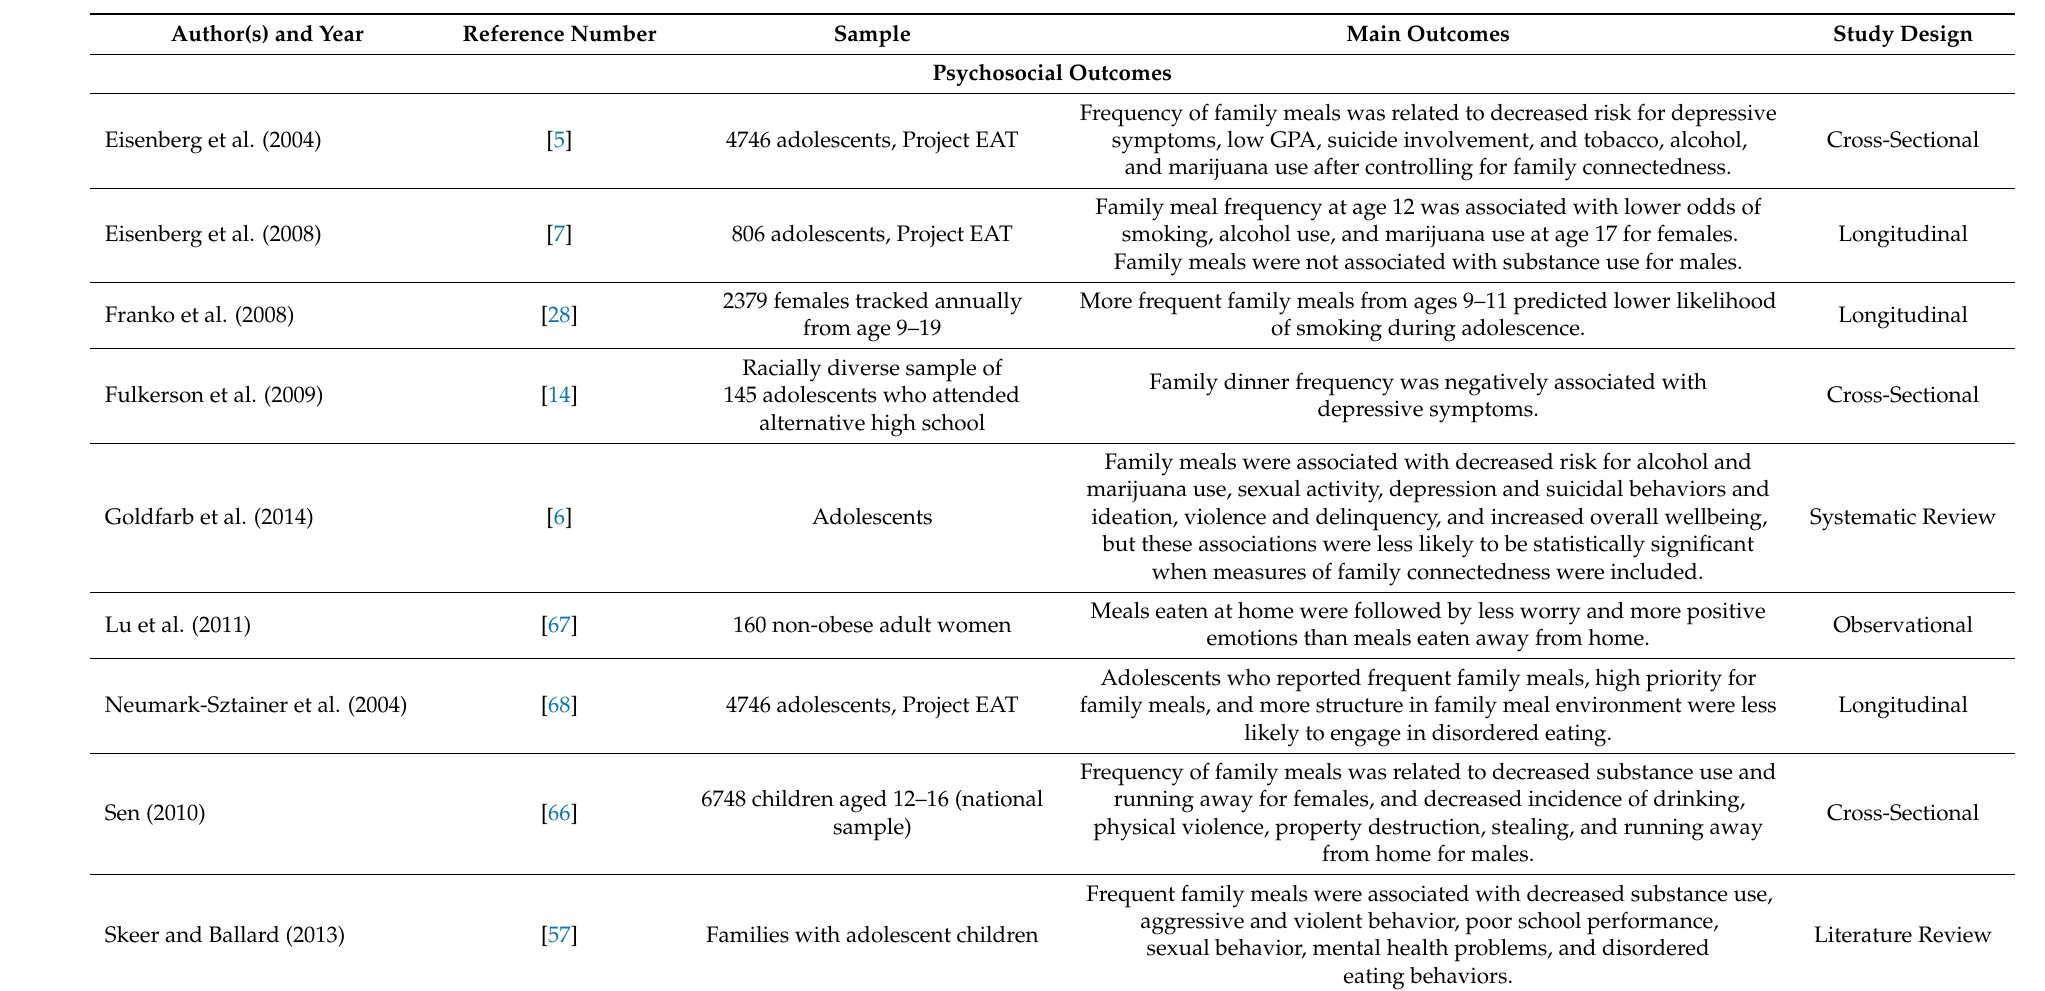
Table 3. Summary of Psychosocial